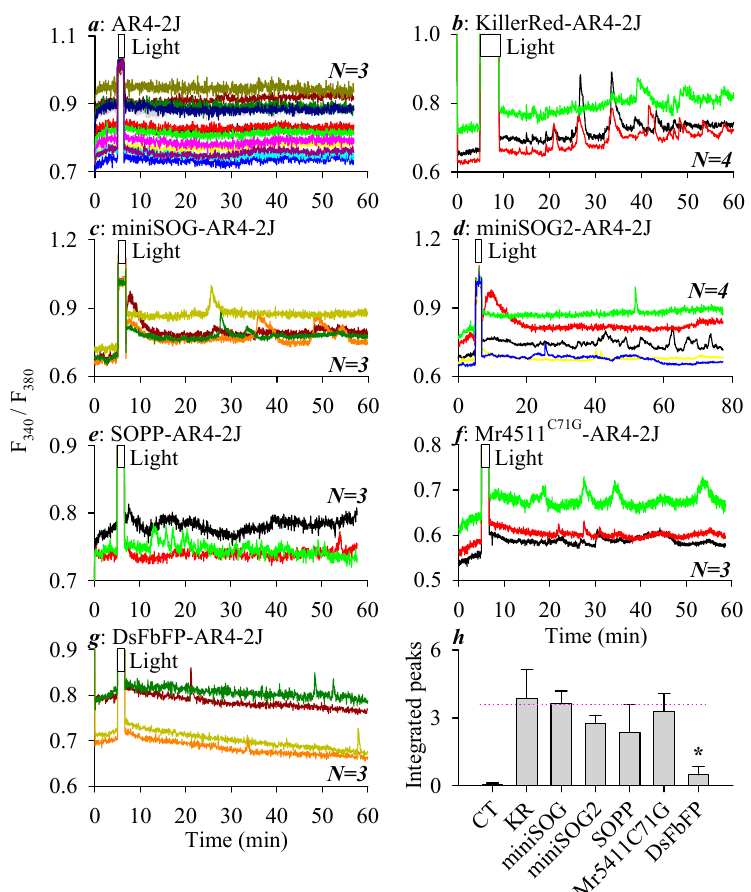
Figure 2. Photodynamic CCK1R activation with genetically encoded protein photosensitizers KillerRed, miniSOG, miniSOG2, SOPP, Mr4511, and DsFbFP. Fura-2 AM-loaded AR4-2J ( a ), KillerRed PM -AR4-2J ( b ), miniSOG PM -AR4-2J ( c ), miniSOG2 PM -AR4-2J ( d ), SOPP PM -AR4-2J ( e ), Mr4511 C71G PM ( f ), and DsFbFP-AR4-2J cells ( g ) were perfused, and LED light ( a , c – g , 450 nm, 85 mW · cm − 2 , 1.5 min) or white light ( b , 85.3 mW · cm − 2 , 4 min) was applied, as indicated by the horizontal bars. LED light (450 nm, 85 mW · cm − 2 , 1.5 min) irradiation of AR4-2J cells ( a , N = 4 ). White light irradiation (85.3 mW · cm − 2 , 4 min) of KillerRed PM -AR4-2J cells ( b , N = 4 ). LED light (450 nm, 85 mW · cm − 2 , 1.5 min) irradiation of miniSOG PM -AR4-2J ( c , N = 3 ), miniSOG2 PM -AR4-2J ( d , N = 4 ), SOPP PM - AR4-2J ( e , N = 3 ), Mr4511 C71GPM -AR4-2J ( f , N = 3 ), or DsFbFP-AR4-2J ( g , N = 3 ) cells. The colored calcium tracings in ( a – g ) were each from individual cells from one of N (as indicated) identical experiments, ordinate being the fluorescence ratios in F 340 / F 380 and abscissa being time in min, as indicated. Integrated calcium peaks (per 10 min) in calcium tracings as represented in ( a – g ) from N experiments were calculated and plotted as a bar graph ( h ). The thin, pink, dashed horizontal line in ( h ) indicates the level of miniSOG photodynamic effect. No statistical difference was found between miniSOG and KillerRed (KR) or miniSOG2, SOPP, Mr4511 C71G , but the DsFbFP photodynamic effect was significantly less compared with miniSOG ( p < 0.05), as indicated by an asterisk ( * ). CT: control— parental AR4-2J cells not transfected with any genetically encoded protein photosensitizer (GEPP). The baseline calcium level remained flat after blue LED light irradiation (450 nm, 85 mW ‧ cm − 2 , 1.5 min) in parental AR4-2J cells (Figure 2a). Baseline calcium remained flat as well in KillerRed PM -, miniSOG PM -, miniSOG2 PM -, SOPP PM -, Mr4511 C71GPM -, and DsFbFP PM -AR4-2J cells without light